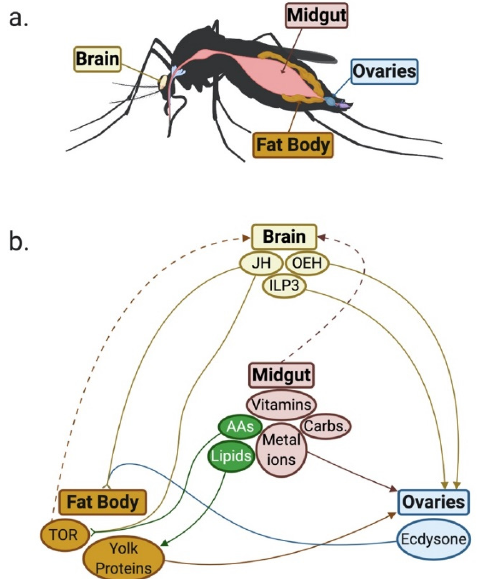
Figure 1. ( a ) Female Aedes aegypti organs involved in blood-meal digestion and subsequent egg production. ( b ) Female Aedes aegypti nutritional and hormonal signals stimulated by blood-meal. JH: juvenile hormone, OEH: ovary ecdysteroidogenic hormone, ILP3: insulin-like peptide 3, Trypsin prot.: Trypsin proteases, TOR: target of rapamycin, S6K: S6 kinase, Vg: vitellogenin, AAs: amino acids, Carbs.: carbohydrates. Green icons indicate metabolites that are modulated by the presence of Wolbachia . Solid arrows indicate metabolite release and delivery, solid arrows with splayed arrowheads indicates two metabolites working synergistically together and dotted arrows indicate upregulation/release of target metabolite. Figure created with